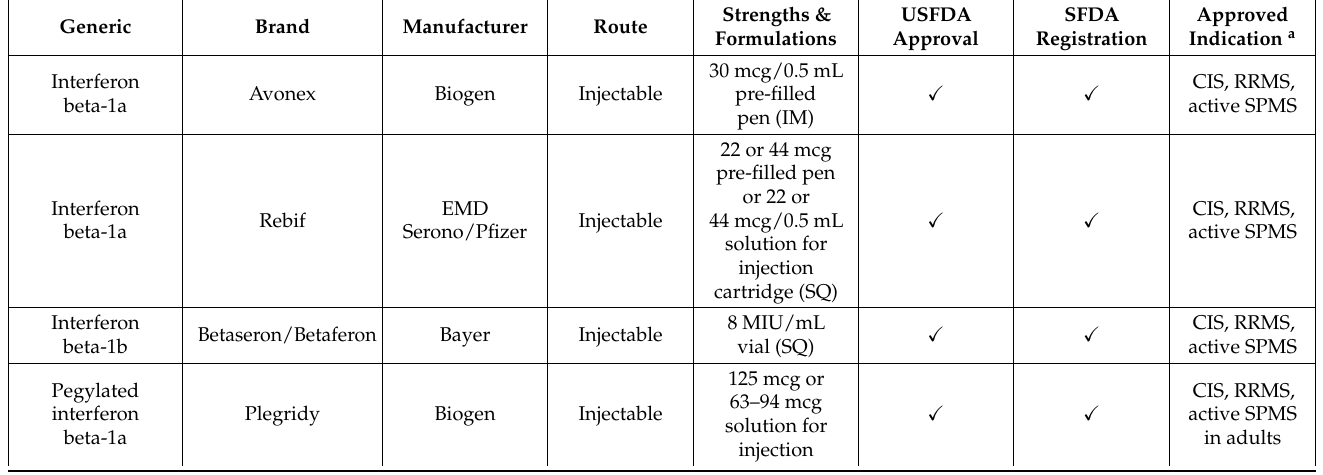
Table 1. Disease-modifying therapies for MS currently available in Saudi